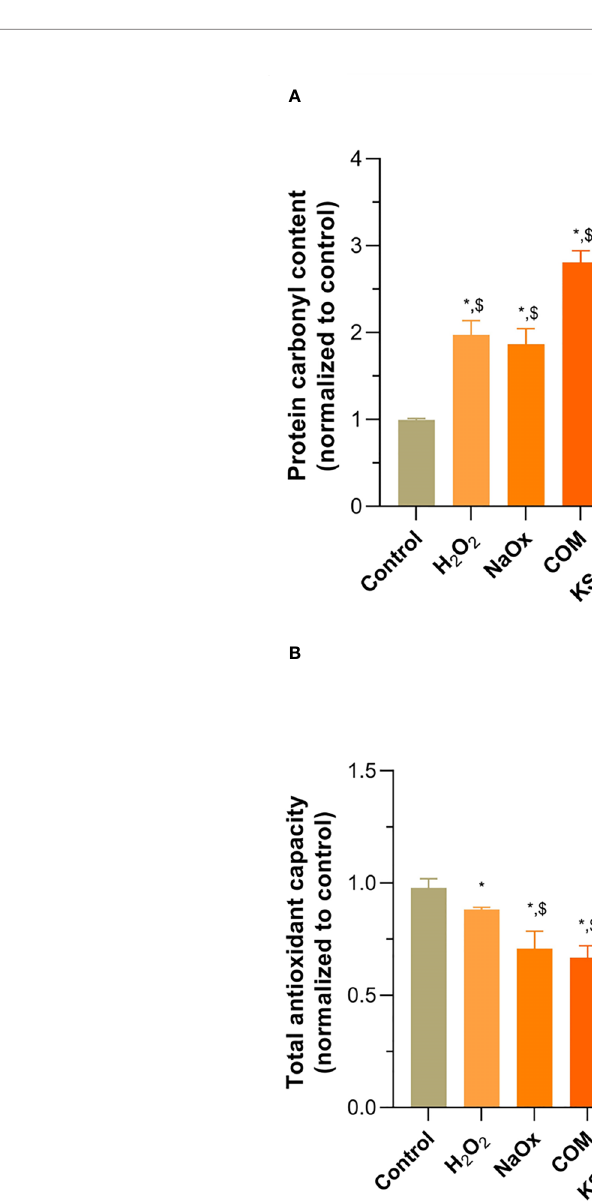
FIGURE 2 | Oxidative stress induced by treatment of HK-2 cells with H 2 O 2 , sodium oxalate (NaOx), calcium oxalate monohydrate (COM), or urine from people with kidney stones (KS). (A) Levels of protein carbonylation after treatment with H 2 O 2 , NaOx, COM, or urine from patients with KS (KS urine) were signi fi cantly higher than those in untreated controls and after treatment with urine from patients without KS (NS urine). Inset: protein carbonyl level after treatment with individual samples of urine from patients with KS (KS samples) compared with treatment with individual samples from donors without KS (NS samples). (B) Total oxidant capacity (TAC) levels in HK-2 cells treated with H 2 O 2 , NaOx, COM, or urine from patients with KS were signi fi cantly lower than in untreated cells. TAC levels after treatment with NaOx, COM, and KS urine treatments were signi fi cantly lower than after treatment with NS urine. Inset: TAC level after treatment with individual samples of urine from patients with KS (KS samples) compared with treatment with individual samples from donors without KS (NS samples). Dashed line and number indicate mean. Error bars indicate SEM of at least triplicate treatments. * P < 0.05 vs. Control, $ P < 0.05 vs. NS